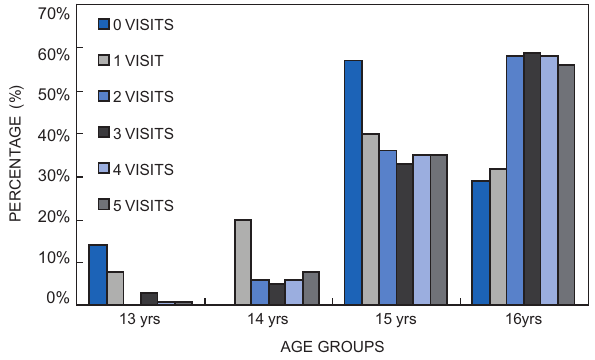
Figure 2: Age stratified by ANC utilisation in young adolescents at a district hospital for the period 2011–2013. 0 visits = nil attendance; 1–3 visits = under-utilisation; 4–5 visits = recommended utilisation ( p =